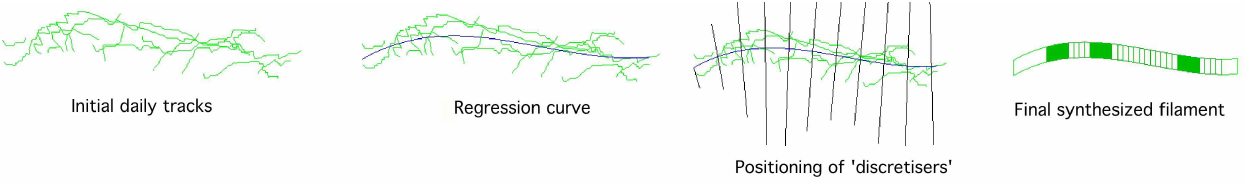
Fig. 4. Sequence of steps describing the method used to compute the synthesis of filament